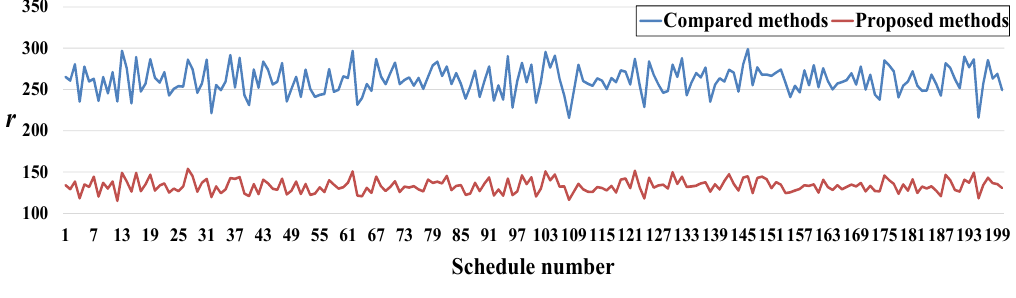
Figure 11. Robustness measure results using two sets of weighting methods.